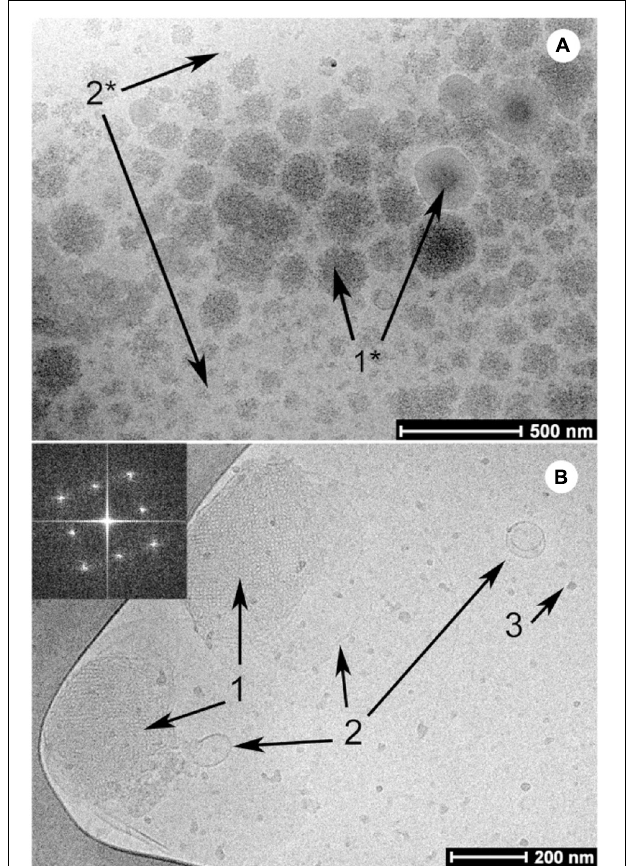
FIGURE 5 | Examples of cryo-TEM images of milk before (A) and after digestion (B) by Salentinig et al., reproduced with permission from Salentinig et al. (2013). Copyright (2013) American Chemical Society. Panel A shows the presence of unstructured emulsion droplets characteristic of bovine milk. The presence of bicontinuous cubic phase (annotated with “1”), lamellar vesicles (annotated with “2”) and protein (annotated with “3”) can be observed in the digested milk in panel B